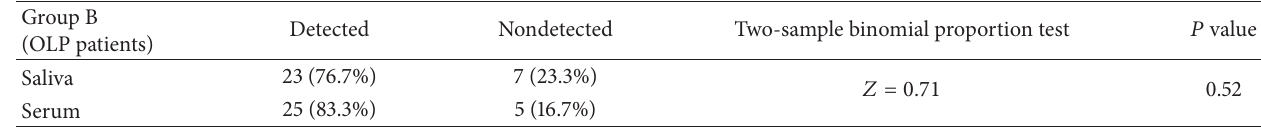
Table 5: Difference in proportion between detected and nondetected TNF- 𝛼 values in saliva and serum of Group B. Group B (OLP patients) Saliva Significant at 𝑃 < 0.05 ; ∗∗ highly significant at 𝑃 < 0.01 ; ∗∗∗ very highly significant at 𝑃 < 0.001 .